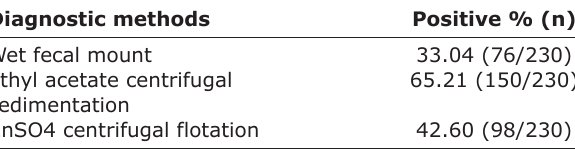
Table-3: The different recovery rate of gastrointestinal parasites according to different coprological